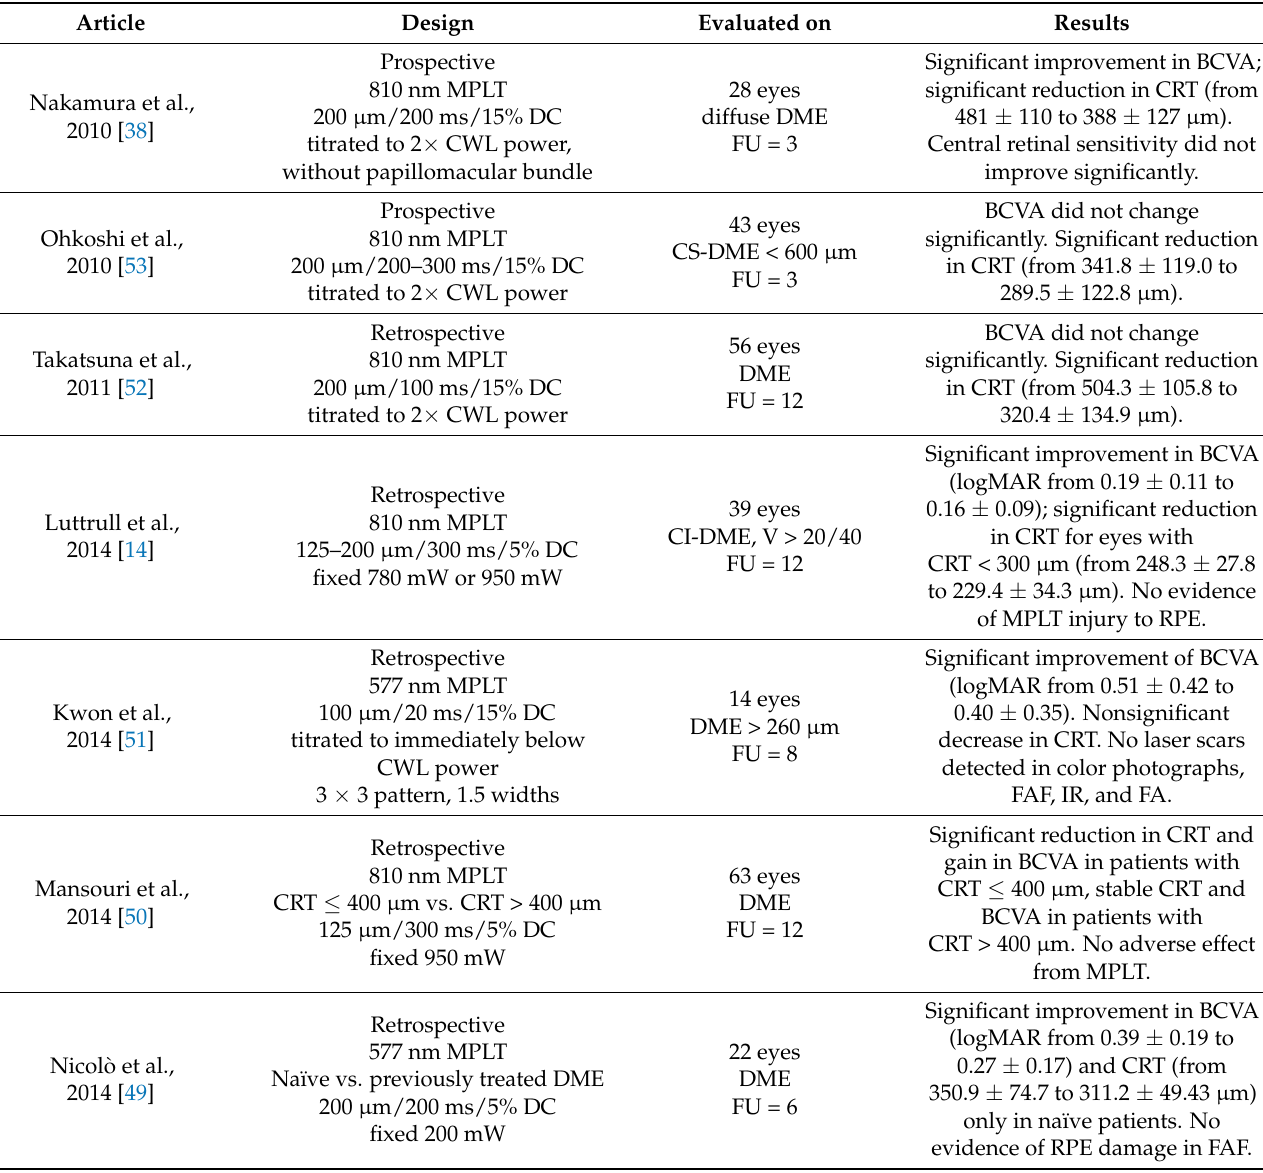
Table 3. Studies on efficacy of MPLT in DME